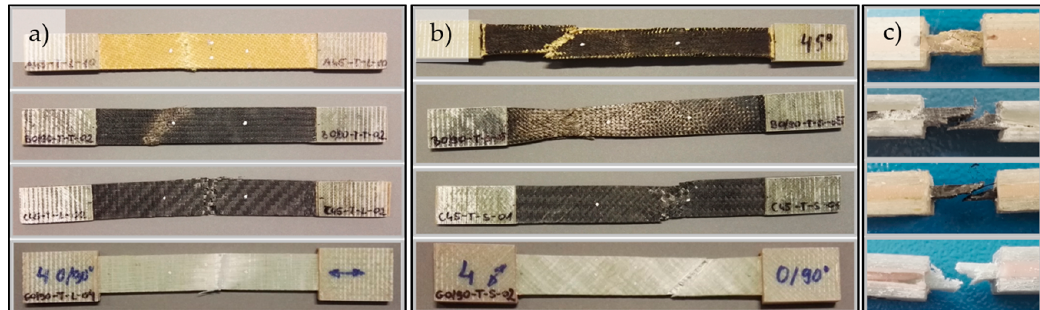
Figure 3. Representative curves for composite specimens with four types of reinforcement for ten- sile tests σ - ε ( left ) and the shear by tensile test τ - ε ( right ).